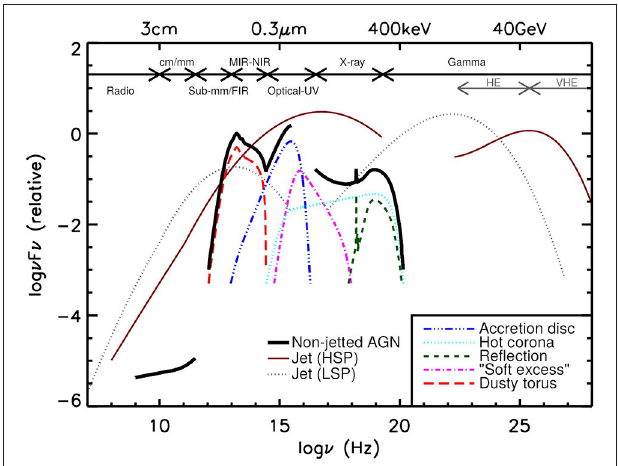
FIGURE 2 | A schematic representation of an AGN spectral energy distribution (SED), loosely based on the observed SEDs of non-jetted quasars (e.g., Elvis et al., 1994; Richards et al., 2006). The black solid curve represents the total emission and the various colored curves (shifted down for clarity) represent the individual components. The intrinsic shape of the SED in the mm-far infrared (FIR) regime is uncertain; however, it is widely believed to have a minimal contribution (to an overall galaxy SED) compared to star formation (SF), except in the most intrinsically luminous quasars and powerful jetted AGN. The primary emission from the AGN accretion disk peaks in the UV region. The jet SED is also shown for a high synchrotron peaked blazar (HSP, based on the SED of Mrk 421) and a low synchrotron peaked blazar (LSP, based on the SED of 3C 454.3). Adapted from Harrison (2014). Image credit: C. M. Harrison. Figure reproduced from Padovani et al. (2017), Figure 1, with permission of